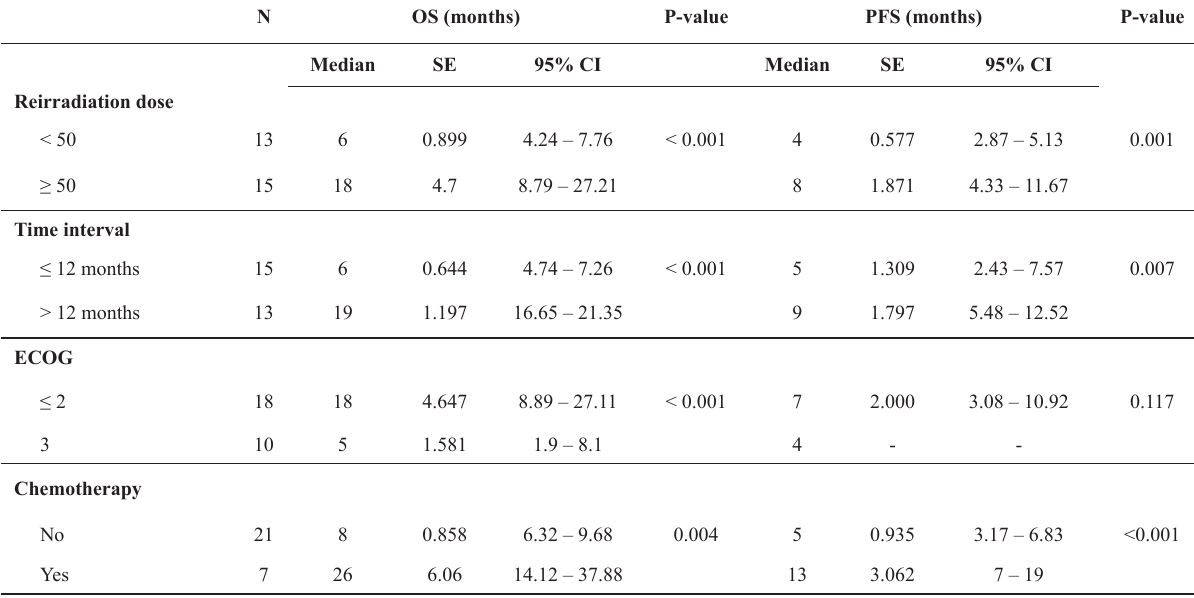
Table 4: Univariate analysis of